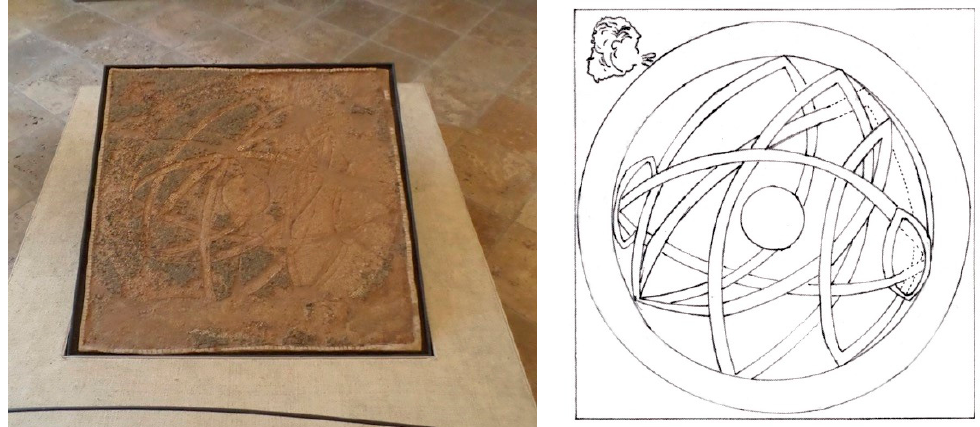
Figure 5. Soluntum, House of Leda, room f’s original mosaic panel, now in the Soluntum Archaeological Museum ( Left , photo by author) and schematic drawing ( Right , after De Vos 1975, p. 214).